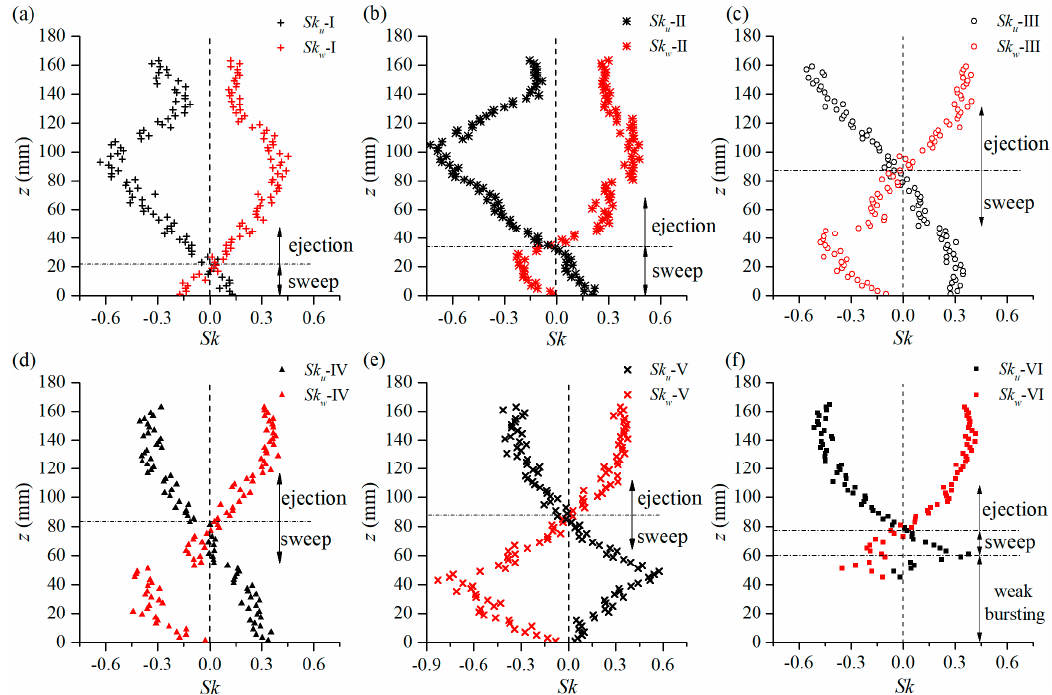
Figure 7. Sk u and Sk w with different vegetation densities, in ( a ) Case I, ( b ) Case II, ( c ) Case III, ( d ) Case IV, ( e ) Case V and ( f ) Case VI.